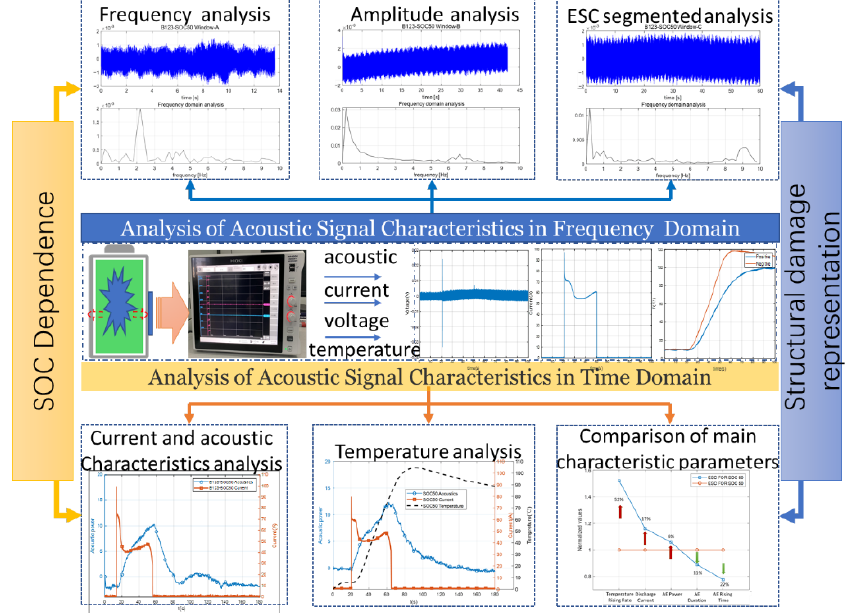
Figure 5. Framework for the acoustic analysis in ESC.